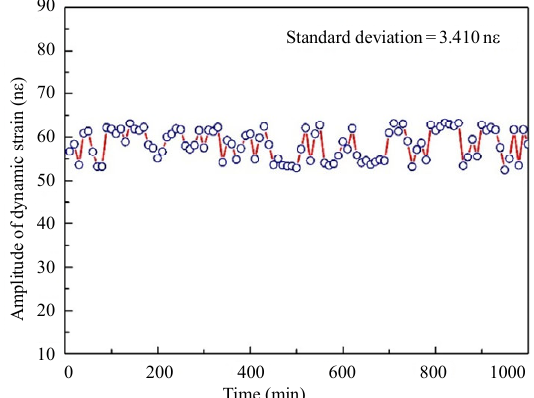
Fig. 13 Demodulated results of 100 dynamic strains in the same environment, and an interval of 10 minutes is set between each